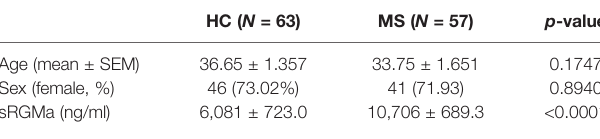
TABLE 1 | Demographic features of clinical participants.